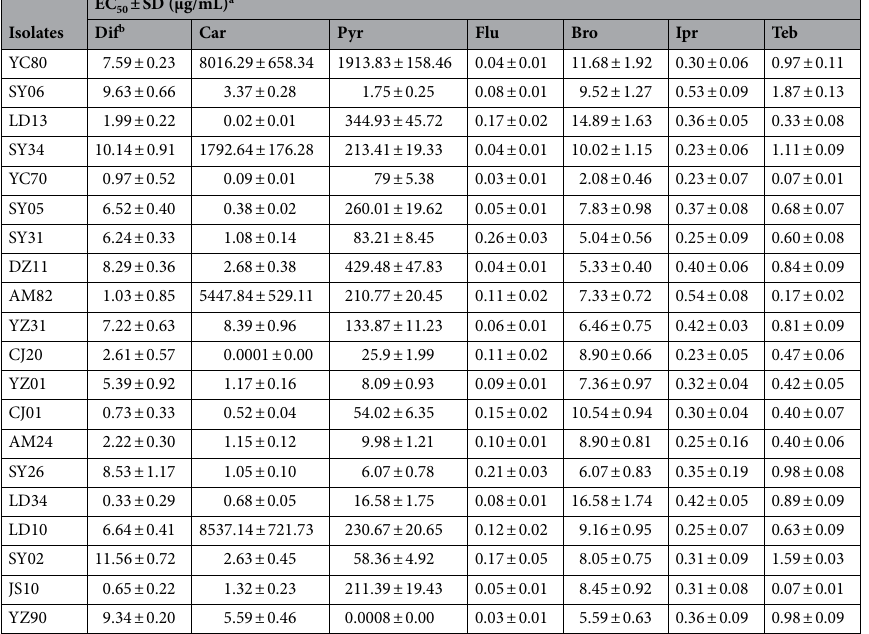
Table 2. The EC 50 values of Lasiodiplodia theobromae isolates to seven fungicides. a Values in a column indicate EC 50 means ± standard deviation (SD). b Dif difenoconazole, Car carbendazim, Pyr pyraclostrobin, Flu fludioxonil, Bro bromothalonil, Ipr iprodione, Teb